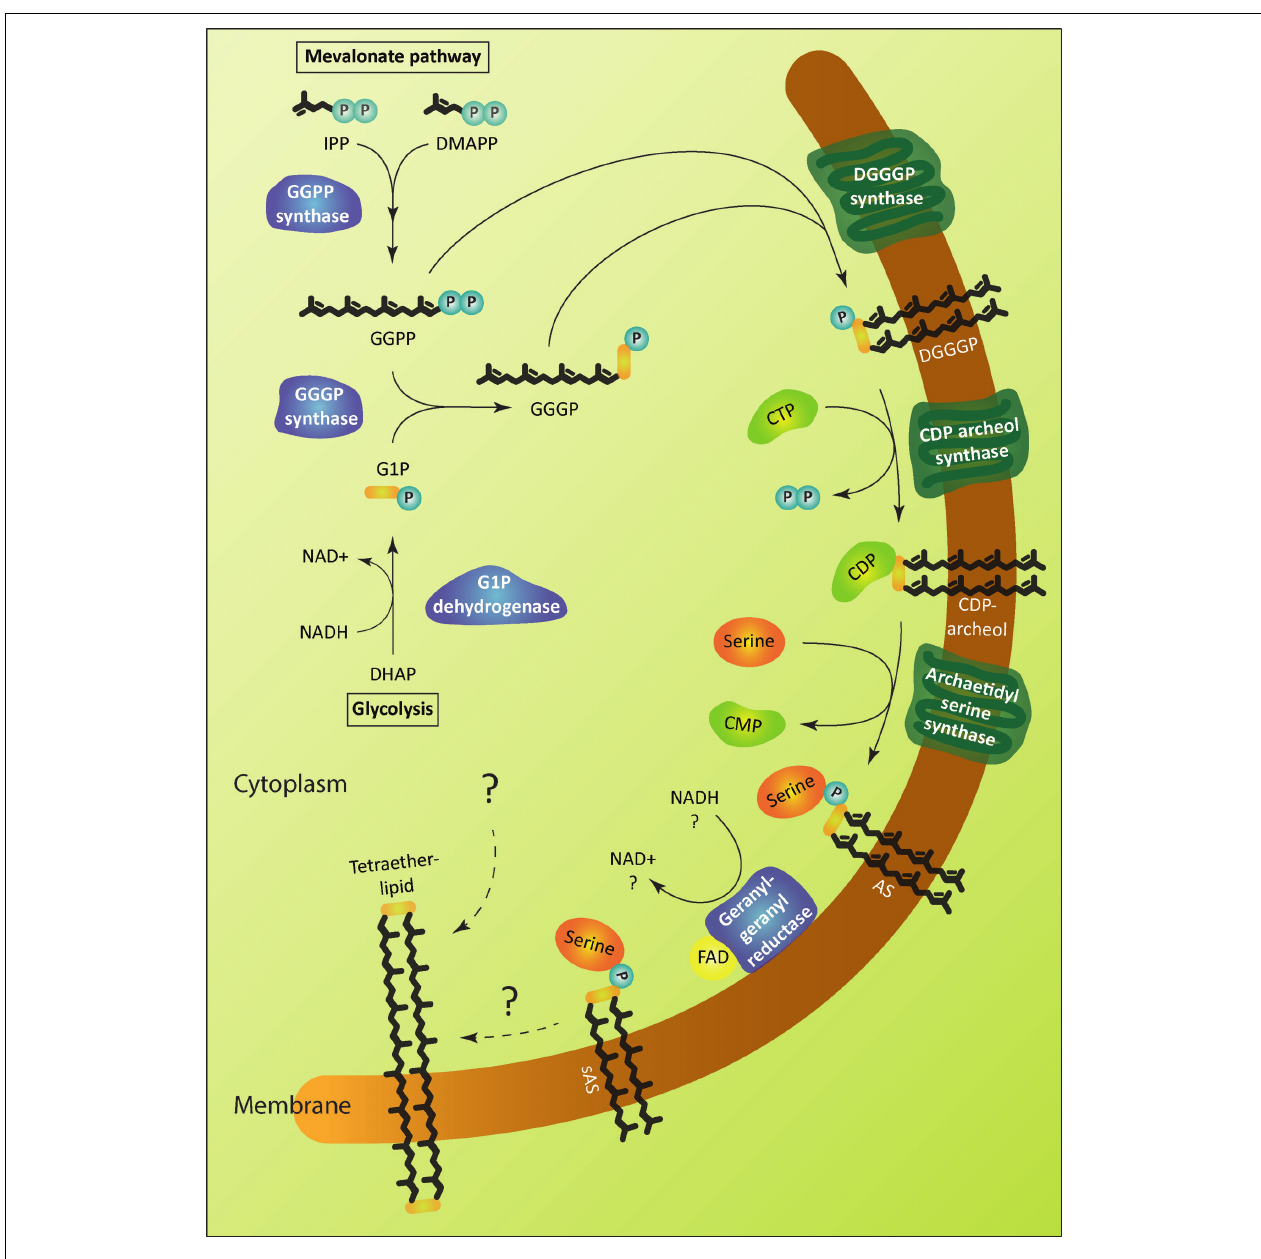
FIGURE 2 | Enzymatic pathway of archaeal lipid biosynthesis. The soluble enzymes of the pathway are colored in blue and the membrane proteins in green. The biosynthetic steps leading to the formation of tetraether lipids is unknown. Archaetidylserine (AS) and saturated AS (sAS) are depicted as an example of polar head